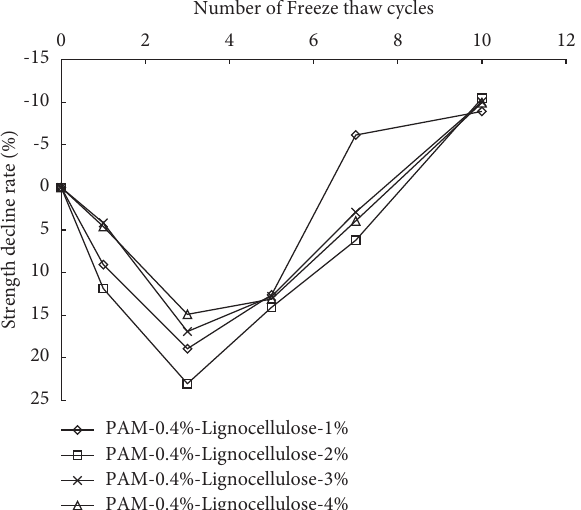
Figure 23: Changes of strength decrease of PAM and lignocellulose-stabilized specimens with freeze-thaw cycles.